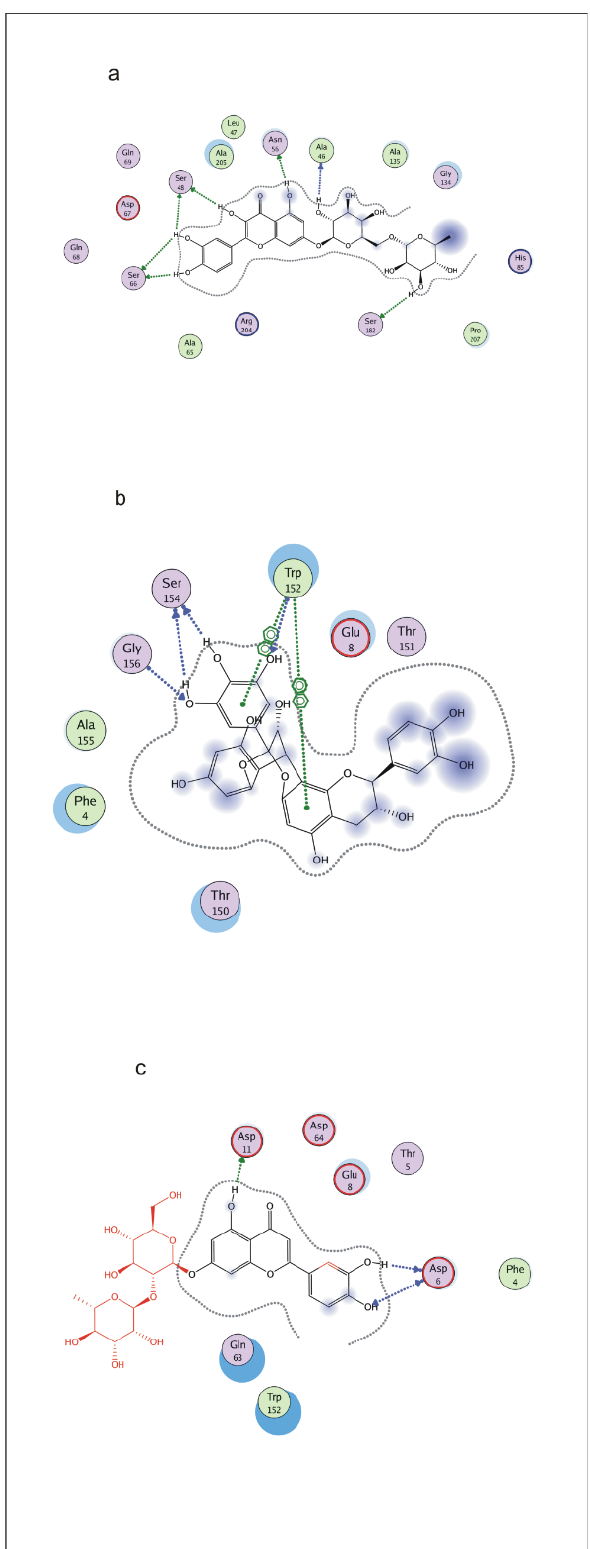
Figure 7. Two ‐ dimensional interaction view of flavonoid atoms with specific residues in active site Figure 7. Two-dimensional interaction view of flavonoid atoms with specific residues in ac- of V protein. Here, dots are showing specific interactions with ( a ) querce ‐ tive site of V protein. Here, dots are showing specific interactions with ( a ) quercetin-7-O-[ α -L- tin ‐ 7 ‐ O ‐ [ α‐ L ‐ rhamnopyranosyl(1 → 6) ‐β‐ D ‐ galactopyranoside], ( b ) epigallocate ‐ rhamnopyranosyl(1 → 6)- β -D-galactopyranoside], ( b ) epigallocatechin-(4 β → 8,2 β → O-7)-epicatechin, chin ‐ (4 β → 8,2 β → O ‐ 7) ‐ epicatechin, and ( c ) luteolin 7 ‐ O ‐ neohesperidoside. and ( c ) luteolin